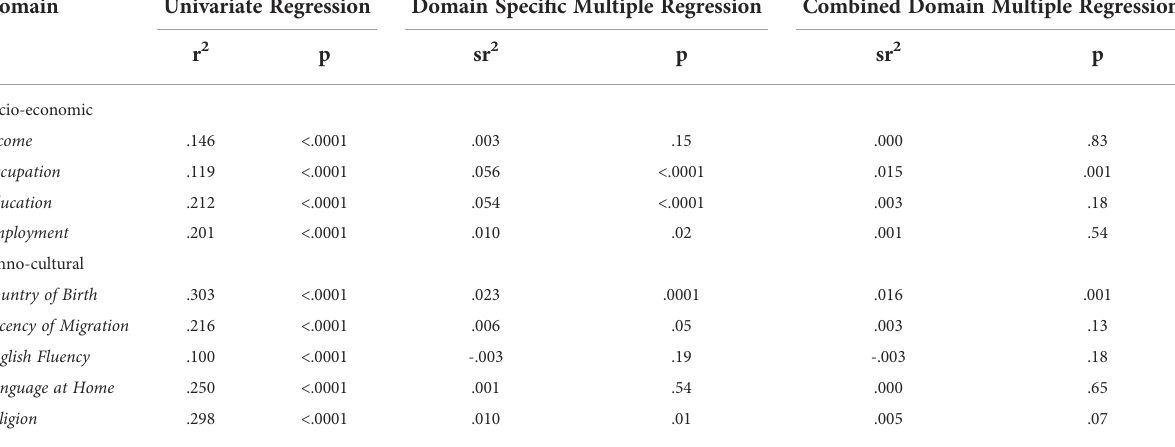
TABLE 1 Relationship of individual socio-economic and ethnocultural domain scores to area-based screening